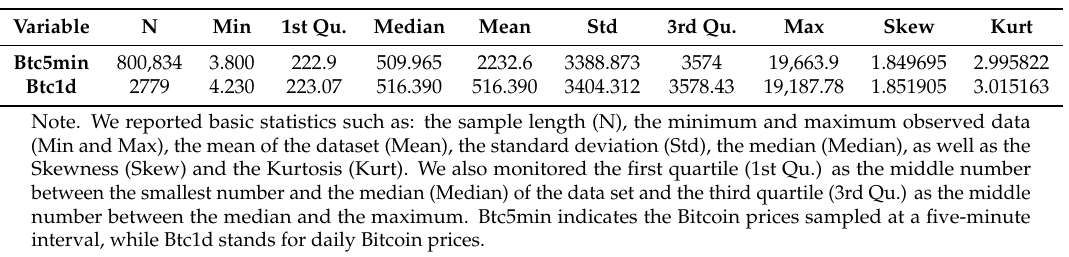
Figure 1. The dynamics of Bitcoin price series: five-minute data ( left panel) and daily data ( right panel). Table 1. Descriptive statistics over the interval 1 January 2012–20 August